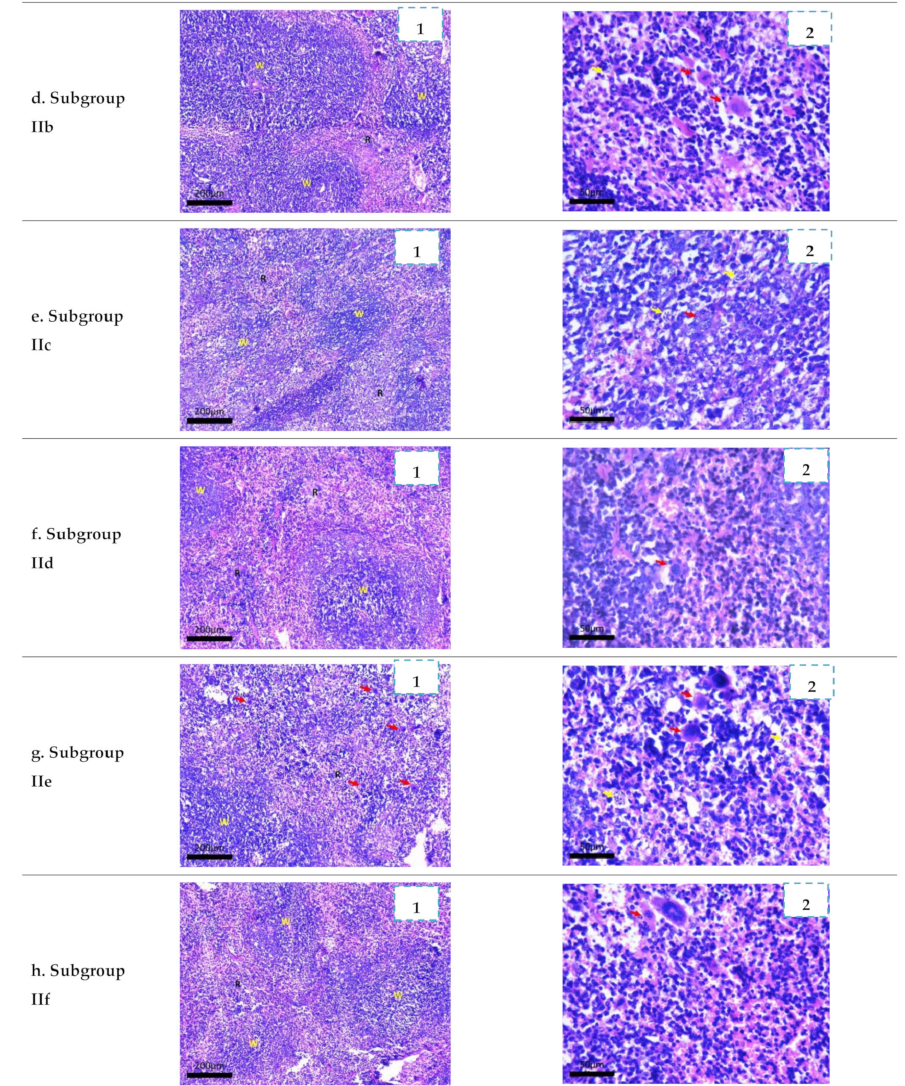
Figure 10. Histopathological spleen sections of different Toxoplasma -infected subgroups: ( a ) Subgroup Ia: ( a1 ) Regression of white pulp (W) and expanded congested red pulp (R) (100 × ). ( a2 ) Red pulp showing microgranulomas composed of scattered epithelioid histiocytes (red arrows) loaded with intracytoplasmic tachyzoites (yellow arrows) (400 × ). ( b ) Subgroup Ib: ( b1 ) Residual congestion of red pulp (R) with slightly atrophic white pulp (W) (100 × ). ( b2 ) Few histiocytes (red arrows) with focally detected tachyzoites (yellow arrow) (400 × ). ( c ) Subgroup IIa: ( c1 ) Minimal improvement. Red pulp (R) is still congested on expanse of white pulp (W) (100 × ). ( c2 ) Numerous epithelioid cells (red arrows) with evident tachyzoites (yellow arrows) (400 × ). ( d ) Subgroup IIb: ( d1 ) Expansion of white pulp (W) and less red pulp congestion (R) (100 × ). ( d2 ) Evident histiocytes (red arrows) with rarely detected tachyzoites (yellow arrow) (400 × ). ( e ) Subgroup IIc: ( e1 ) Expansion of white pulp W) and less red pulp congestion (R) (100 × ). ( e2 ) Few histiocytes (red arrows) with rarely detected tachyzoites (yellow arrows) (400 × ). ( f ) Subgroup IId: ( f1 ) Restoration of normal splenic architecture with normal white pulp (W) and red pulp (R) (100 × ). ( f2 ) Rare histiocytes (red arrows) with no detected tachyzoites (400 × ). ( g ) Subgroup IIe: ( g1 ) Improvement of white pulp (W) and less congestion of red pulp (R) (100 × ). ( g2 ) Rare histiocytes (red arrows) with few tachyzoites (yellow arrows) (400 × ). ( h ) Subgroup IIf: ( h1 ) Restoration of normal splenic architecture with normal white pulp (W) and red pulp (R) (100 × ). ( h2 ) Few histiocytes (red arrows) with no detected tachyzoites (400 ×